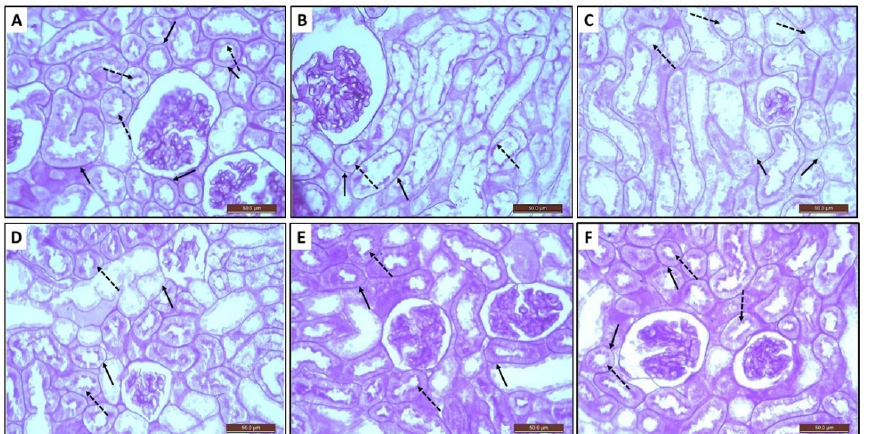
Figure 7. Photomicrographs of renal tissues of all study groups stained with periodic acid Schiff (PAS). ( A , B ): Control and OLE group showing the renal parenchyma with normal architecture as well as positive PAS material expression in the basement membrane (arrow) and the cilia of the proximal convoluted tubules lining epithelium. ( C ): Cis group displayed disorganization of the tubules and shortage of the tubular epithelium expression of positive material of PAS. ( D – F ): Cis + OLE, Cis + CM-MSC, and Cis + MSC groups, respectively. Regeneration of the epithelium of the tubules occurred in the three groups, but was obviously noticed within the last two groups, indicated by the brush border stained positively by PAS. Arrow: basement membrane. Dashed arrow: brush border of tubular epithelium.